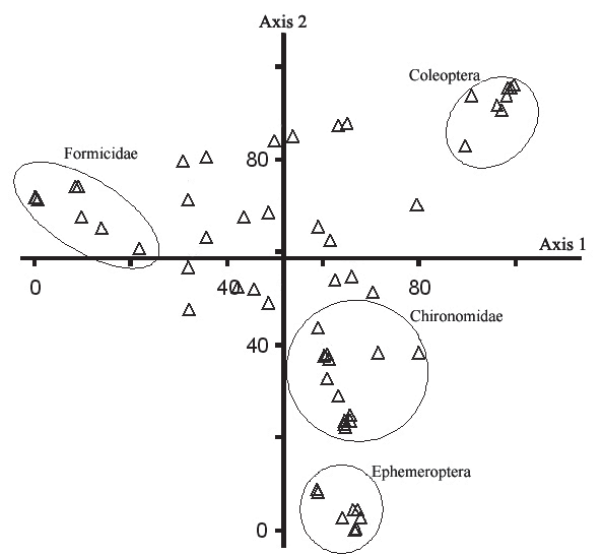
Fig. 4. Principal Components Analysis plot, based on the volumetric proportions of food items consumed by individu- als of Thoracocharax stellatus in the upper rio